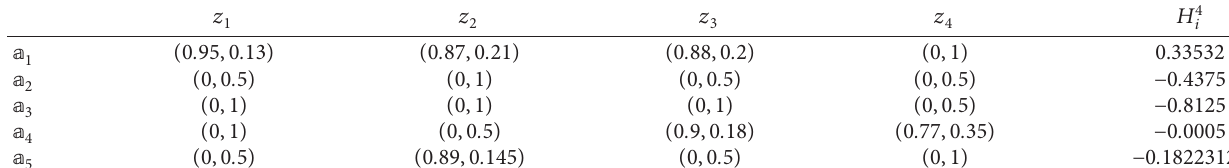
Table 40: Tabular representation of 4 choice value of PF 6 S